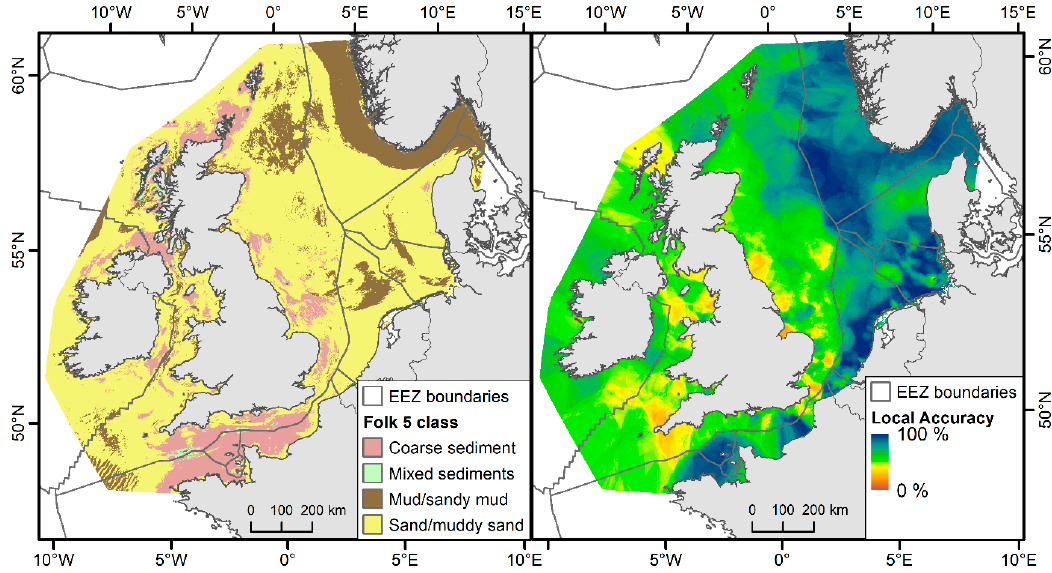
Figure 8. Predicted sediment class based on Folk 5 sediment class definitions and the spatial distribution of accuracy.